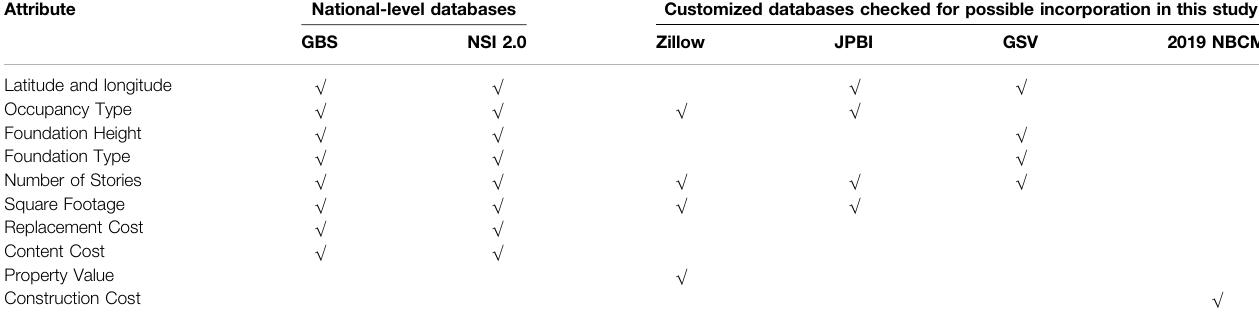
TABLE 2 | Sources of attribute/data used in this study.